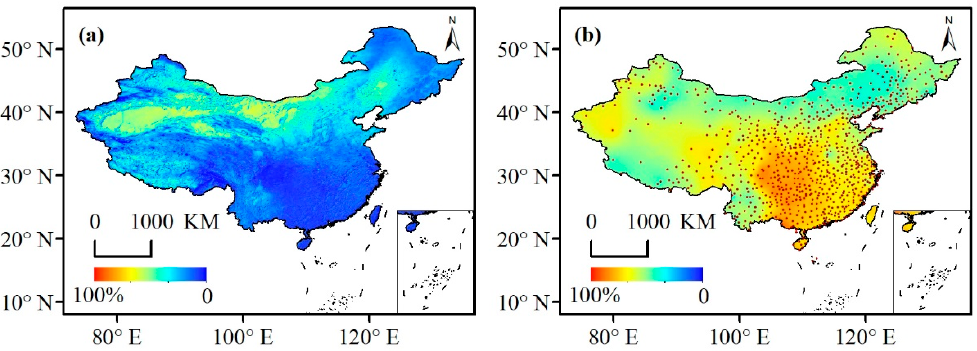
Figure 7. ( a ) The probability of acquiring cloud-free imagery in China. ( b ) The annual average total cloud cover with weather stations in China.